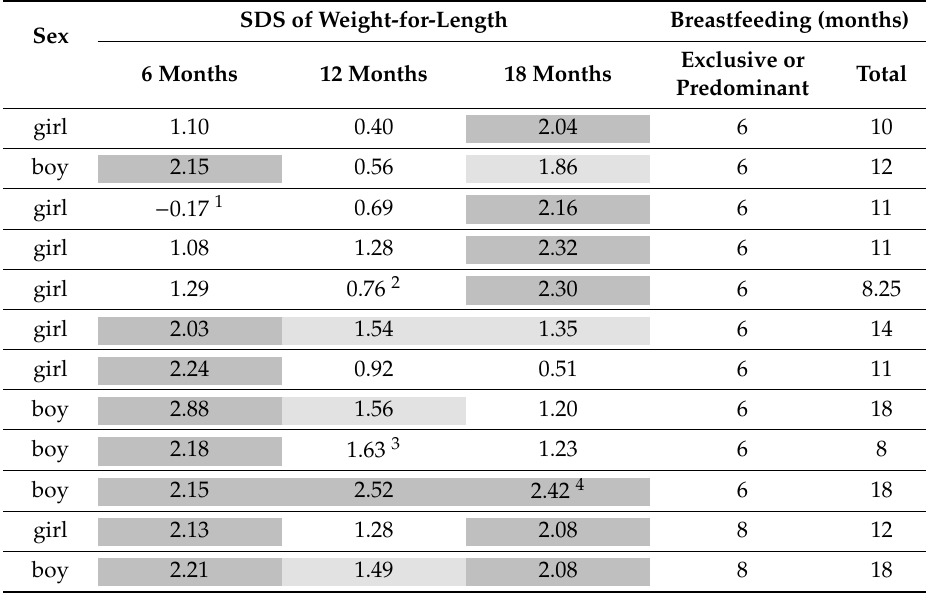
Colors of boxes: light grey = overweight, dark grey = obese, SDS = standard deviation score. 1 6 months examination at the age of 8.05 months. 2 12 months examination at the age of 13.15 months. 3 12 months examination at the